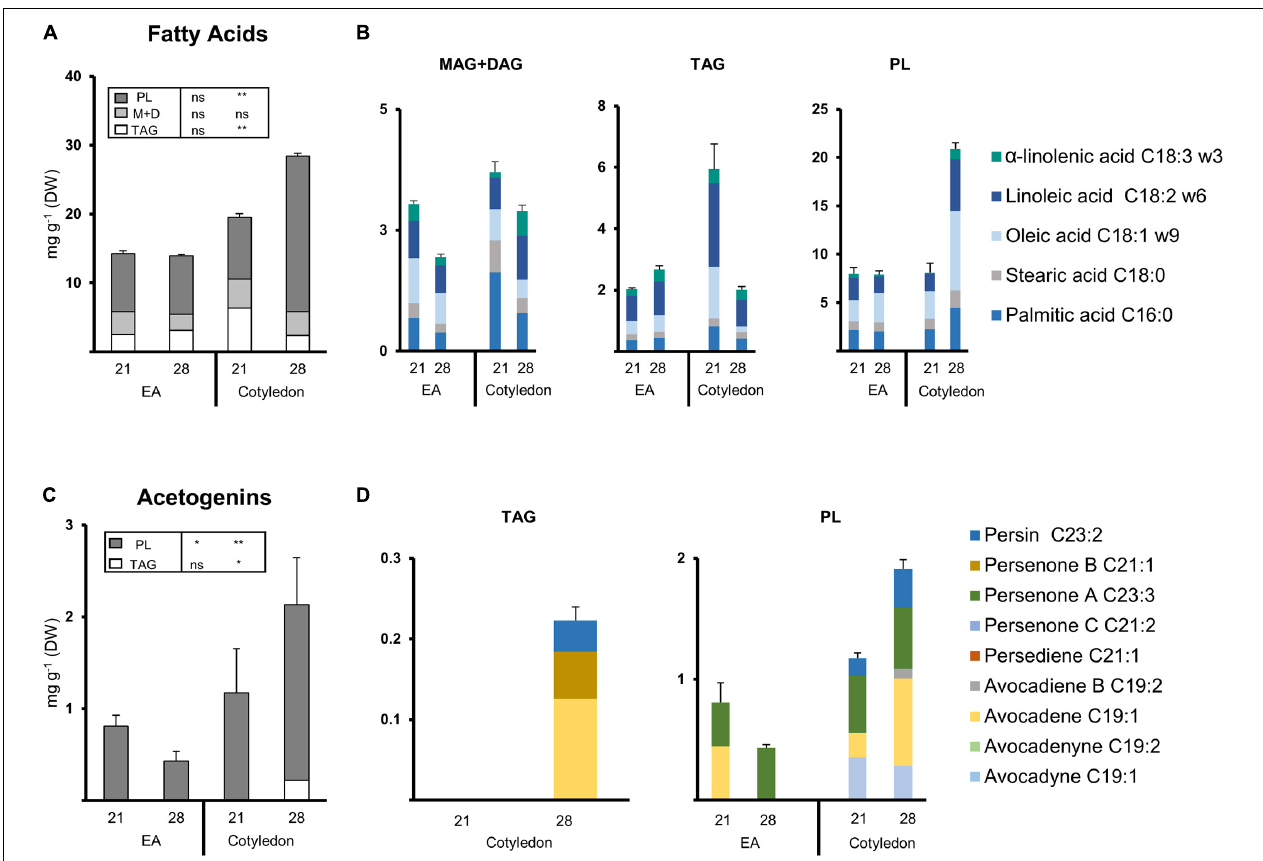
FIGURE 6 | Lipid composition of the EA and cotyledon extracts from two developmental stages. (A) Composition of the fatty acid extracts from EA and COT at 21 and 28 dai. (B) Fatty acid composition of lipid fractions from the EA and Cotyledon at 21 and 28 dai (Left, TAGs; Middle, MAG + DAGs Right, PLs). (C) Composition of the Acetogenin extracts from EA and COT at 21 and 28 dai. (D) Acetogenin composition of lipid fractions from EA and COT at 21 and 28 dai (Left, TAGs; Right, PLs; no FAMEs were detected in the TAG fraction for cotyledon at 21 dai). Bars represent an average of 3 samples. Tables contain statistical differences in between treatments (ANOVA, Fisher LSD, * P < 0.05, ** P < 0.01; ns = non-significant). Error bars indicate Standard Error. PL, polar lipids; MAG, monoacylglycerol; DAG, diacylglycerol; TAG, triacylglycerol. N =